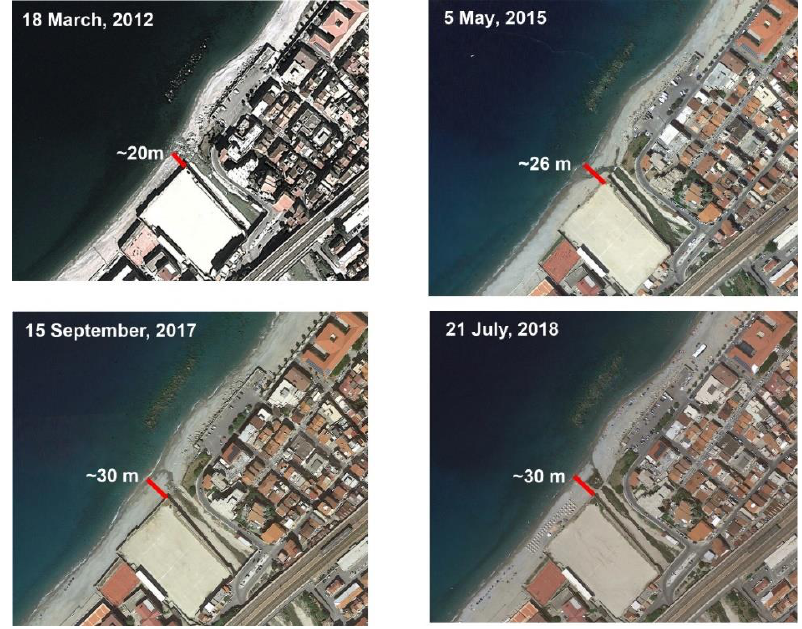
Figure 6. The Google Earth images show a straight coastline shape, during daily condition and a small change of beach width (red lines). Source: own elaboration on the basis of Google Earth images. High-resolution drone images of the fan delta allowed us to identify its distinctive morphological features. The fan delta stands out clearly from the narrow beach,